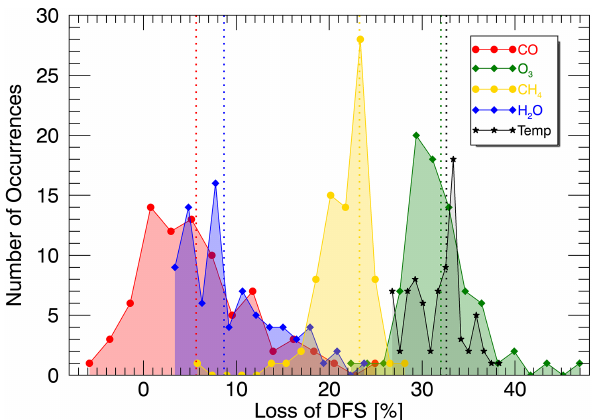
Figure 7. Cumulative diagonals of the AKM for a temperature re- trieval on the 101 level fine grid as well as 18 level coarse grid AKMs (Sects. 3.1–3.3) interpolated to the fine grid.